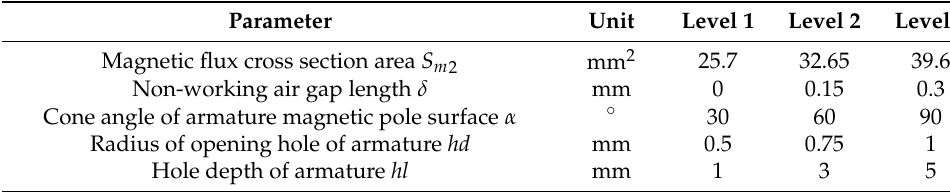
Table 4. Factors level of the key influence parameters.